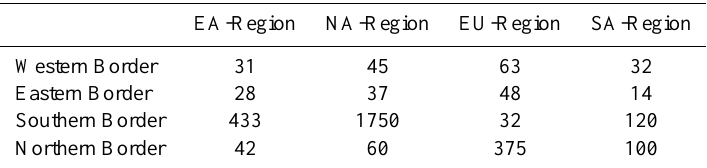
Table 2. The coefficients (%) of variations in annual transport mass of total aerosols across the borders of four HTAP-regions over 1995– 2004.